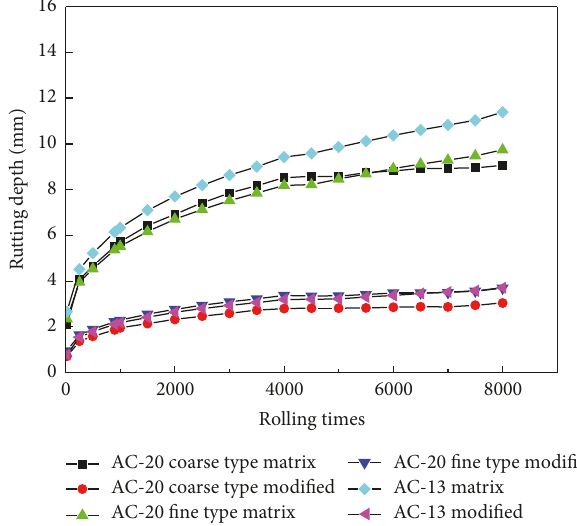
Figure 7: APA rutting depths of asphalt mixtures with 7% air voids at 60 ∘ C under immersing